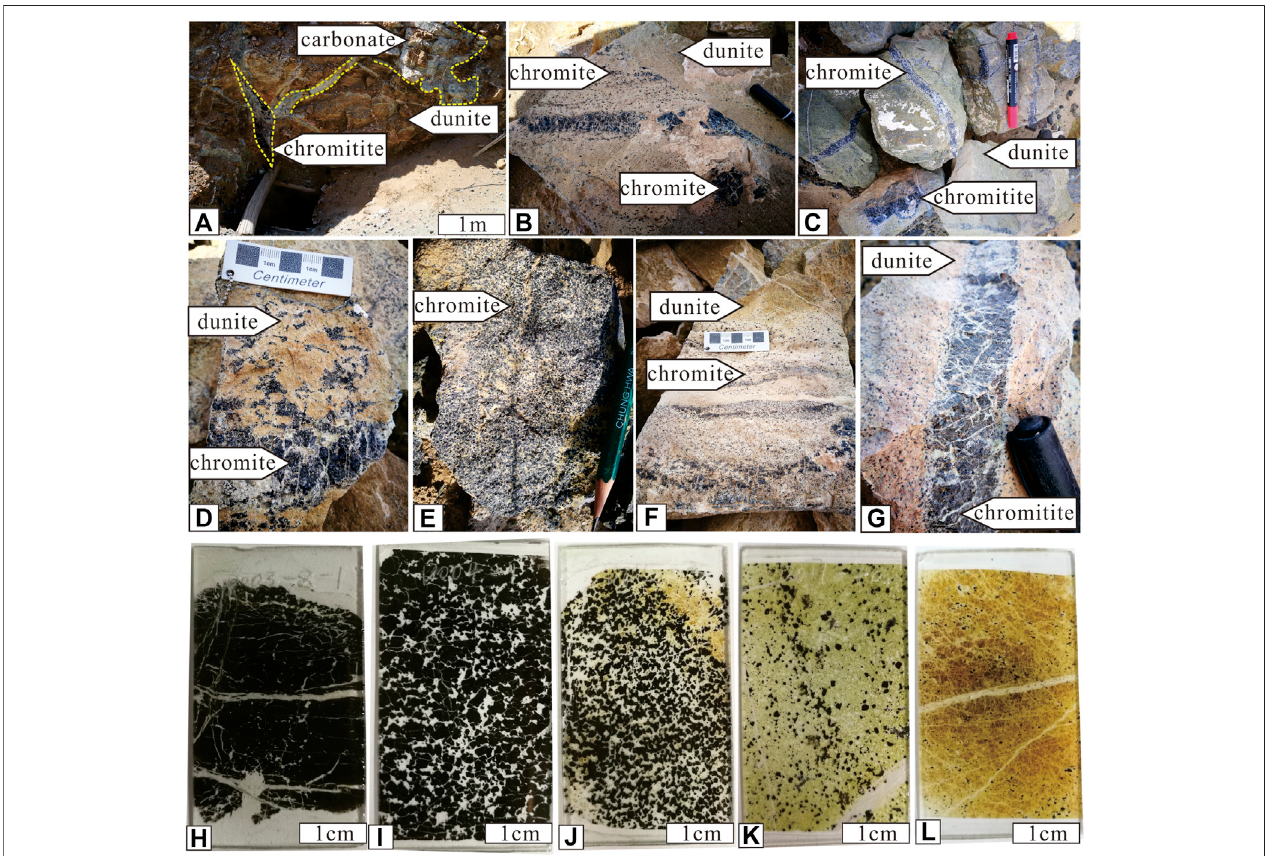
FIGURE 4 | Field and sample photographs of peridotite-hosted chromites in the Hongshishan complex. (A) Lenticular chromite orebody in carbonated dunite; (B) Banded chromite orebody cut by dunite; (C) Veined chromite orebodies in dunite; (D) Brecciated chromites; (E) Dense disseminated chromites; (F) Banded chromite composed of medium density disseminated, sparsely disseminated, and brecciated chromites; (G) Veined chromite crosscutting dunite with sparsely disseminated chromites; (H) Massive chromites; (I) Dense disseminated chromites; (J) Medium density disseminated chromites; (K) Sparsely disseminated chromites; (L) Scattered chromites. ( H – L :